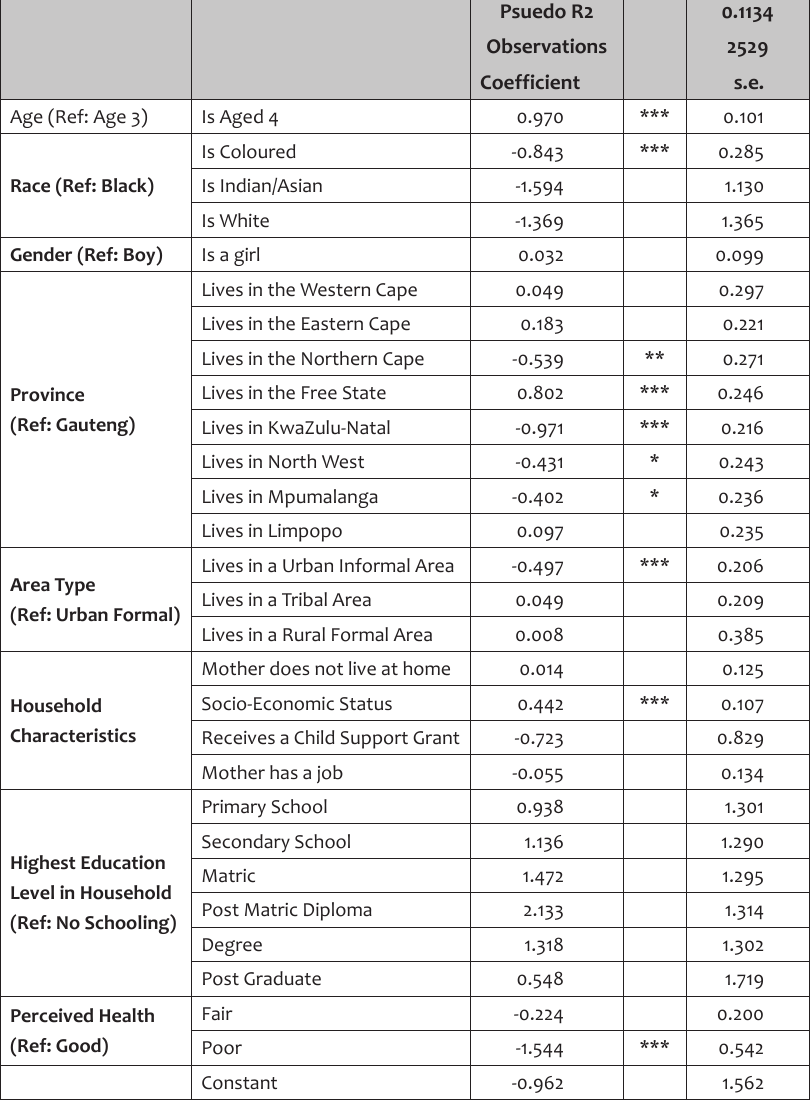
Table 4: Logit model for ages 3 and 4 (Source: SSA 2014